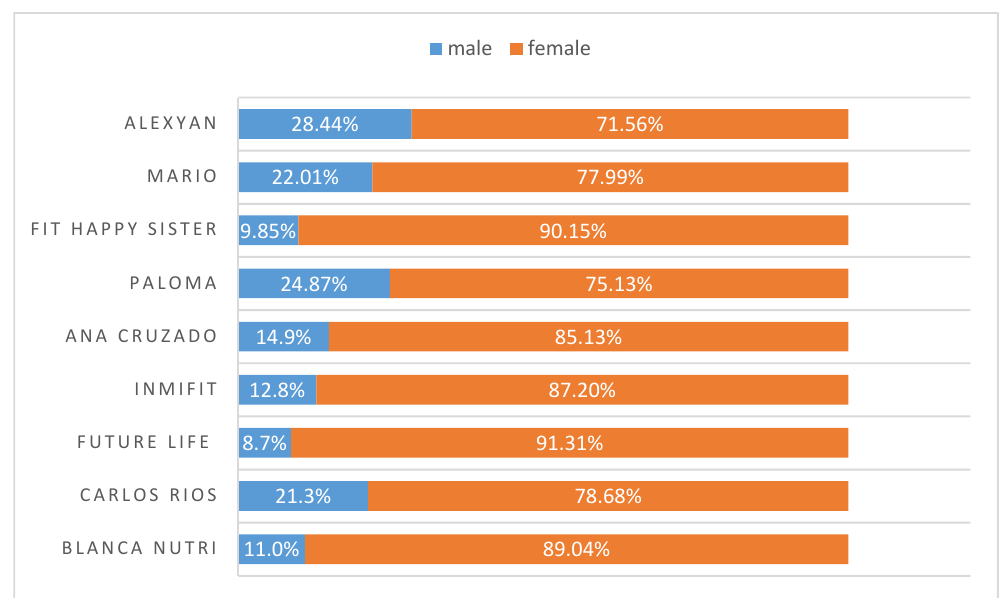
Figure 3. Gender ratio of influencer’s audiences.